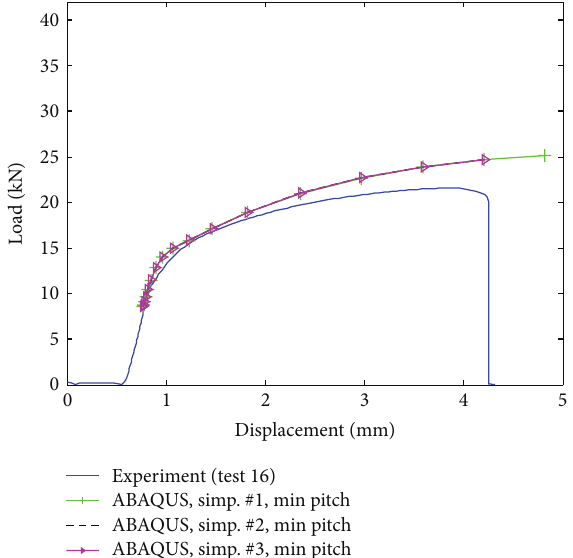
Figure 10: Force-displacement results for static tension test, simpli- fied model